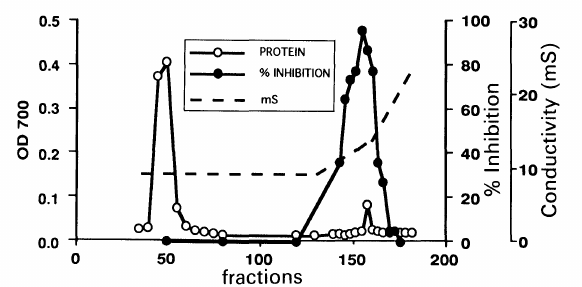
FIG. 1. Affinity chromatography of detergent solubilized endothelial cell membranes on Sepharose-Clq. Protein content (O-C)), conductivity (--) and Clq-R activity (0-0) in the fractions is depicted. Fractions 148-162 were pooled for further purification on QAE-A50.